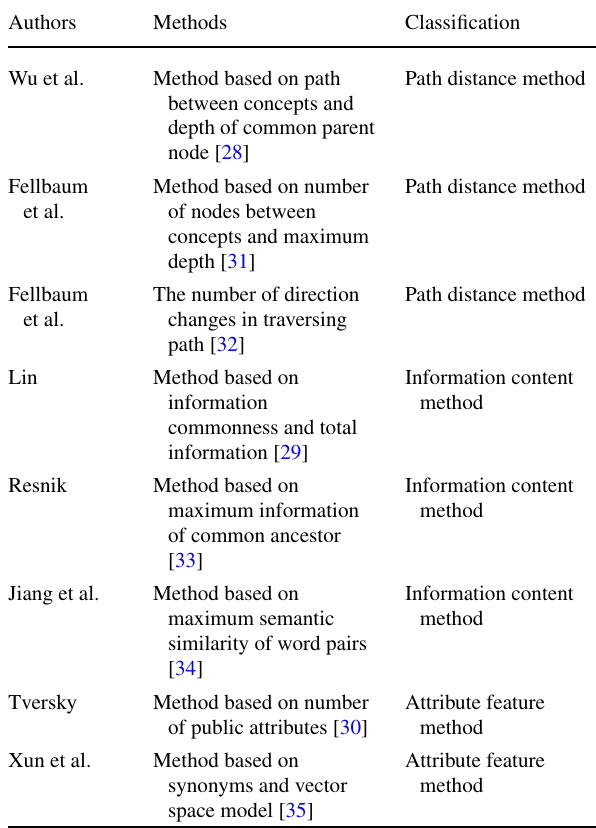
Table 1 Concept semantic similarity calculation methods from typical